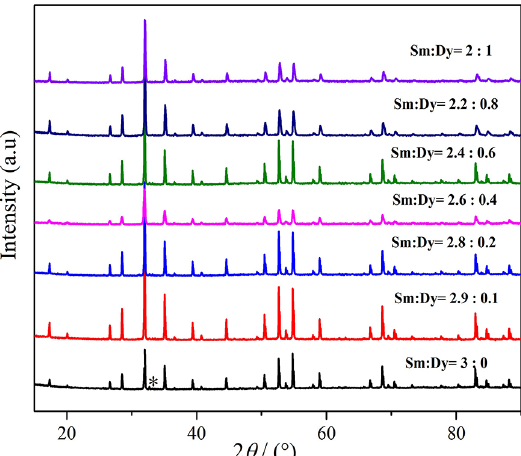
REE Fe O 3− x x 5 12 ). 3